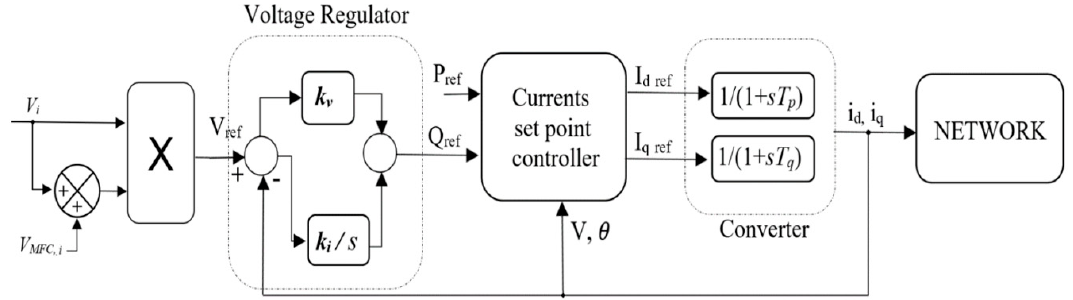
Figure 13. PE-based DER model block diagram including the converter.